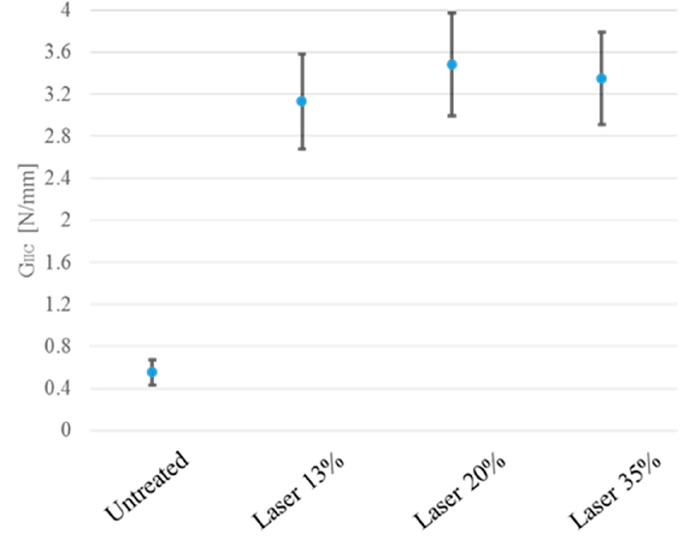
Figure 6. Fracture toughness obtained from experimental tests through the compliance beam method.